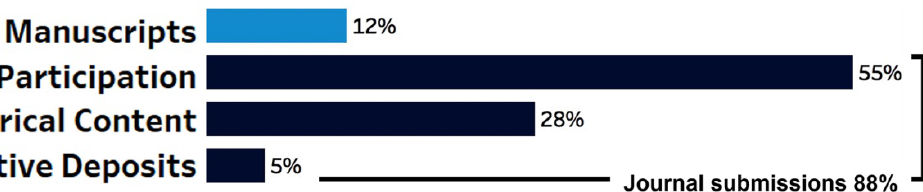
Figure 2 Composition of PubMed Central in